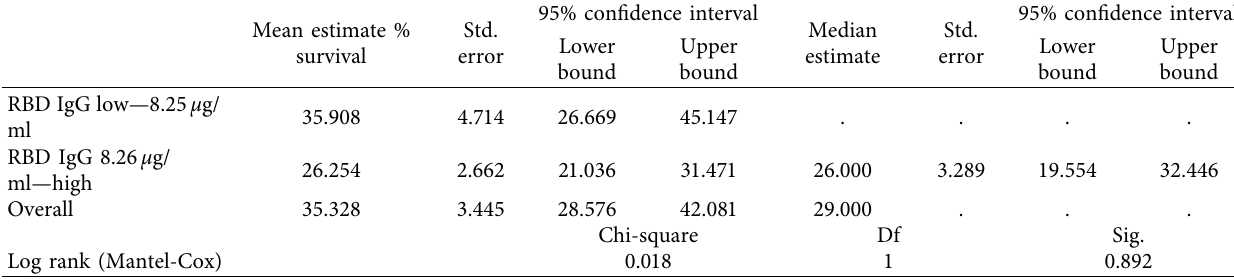
Table 4: Means and medians for survival time for the RBD domain